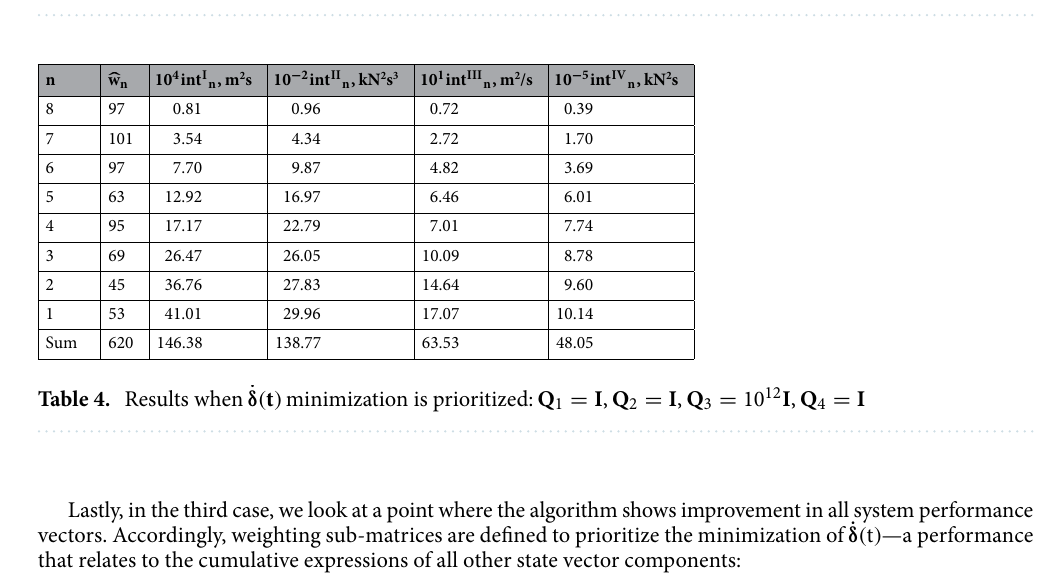
9 I 3 I 6 I , Q 2 = 10 , Q 3 = 10 , Q 4 = I